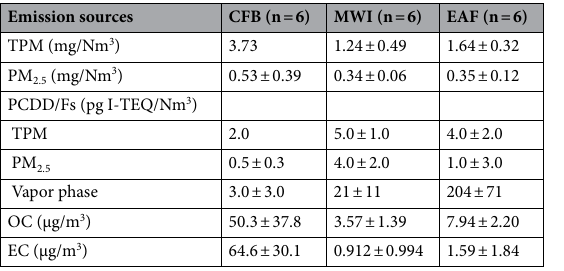
Table 1. Concentration of PM 2.5 , PCDD/Fs and chemical compounds measured in flue gas at different